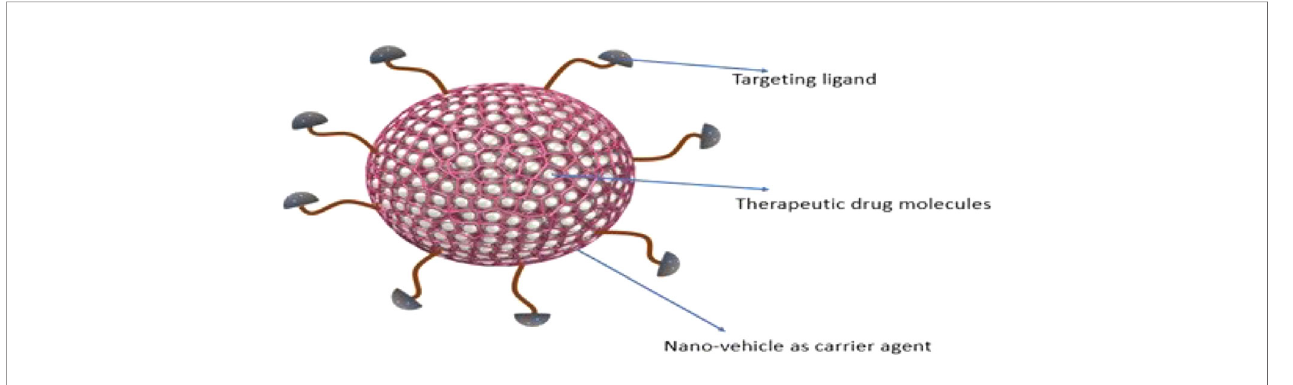
FIGURE 4 | Schematic illustration of nanotherapeutic